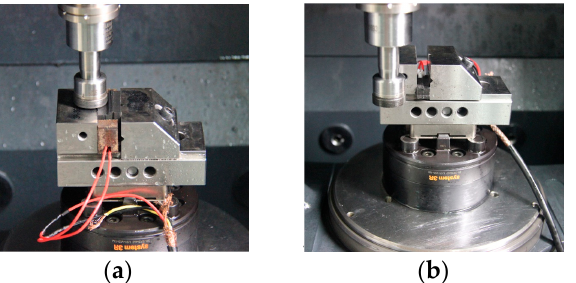
Figure 4. Schematic diagram of ultrasonic vibration-assisted end and side grinding. ( a ) End face grinding. ( b ) Side face grinding.